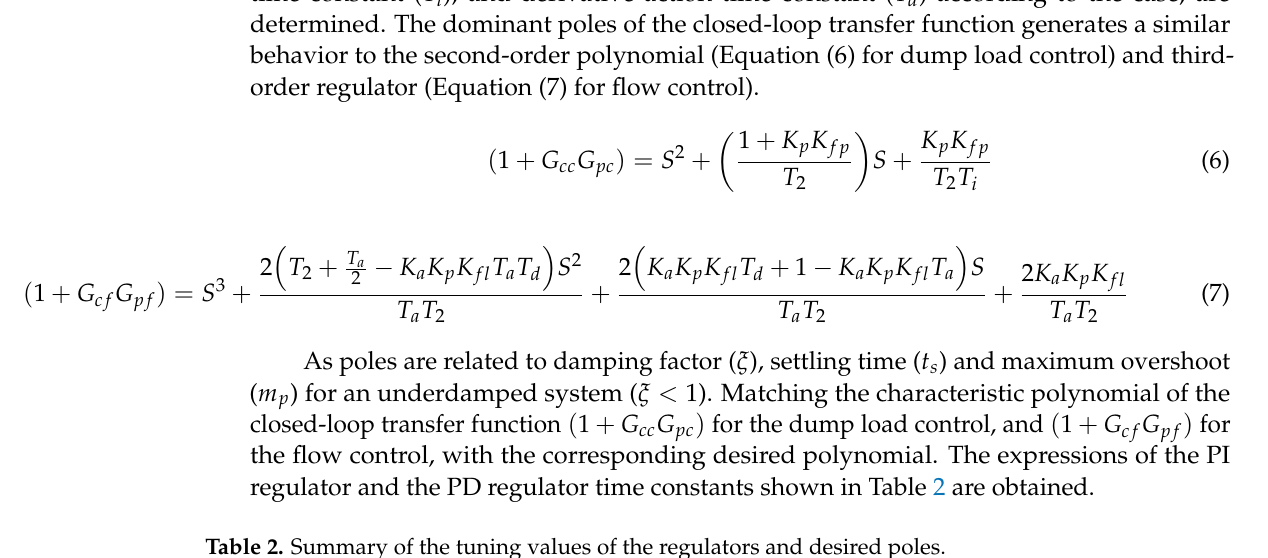
Table 2. Summary of the tuning values of the regulators and desired poles. Type of